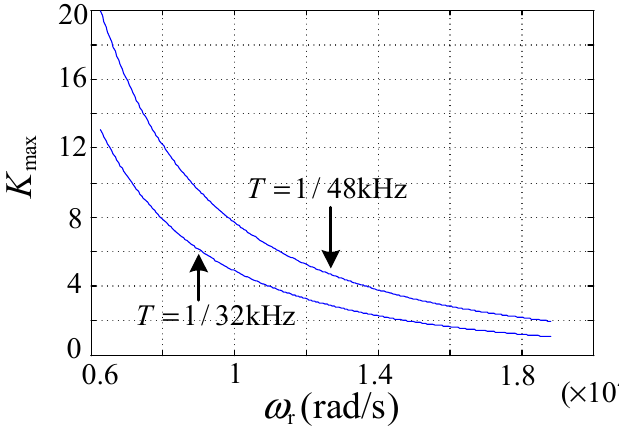
Figure 5. Variation of K max with ω r . Figure 6 shows the pole diagram under the condition of ω r = 10, 000 rad/s,